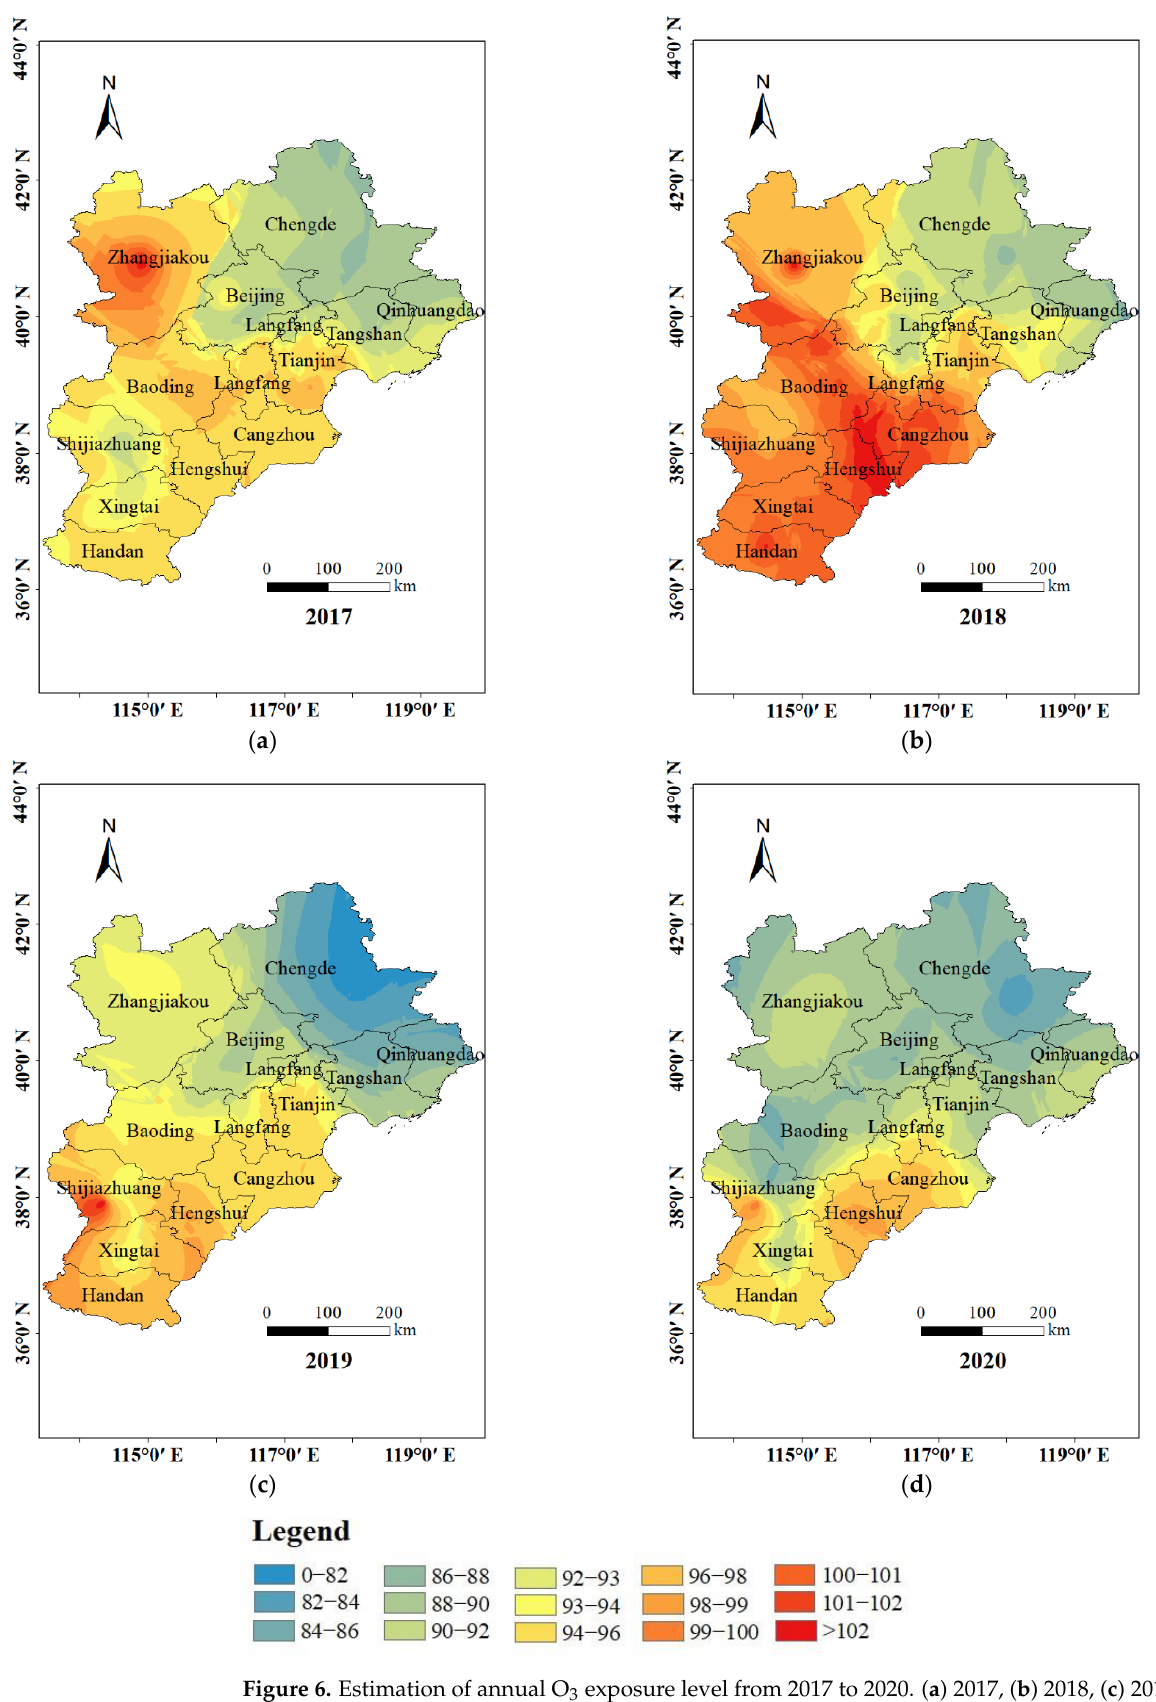
Figure 6. Estimation of annual O 3 exposure level from 2017 to 2020. ( a ) 2017, ( b ) 2018, ( c ) 2019, and ( d ) 2020, respectively.